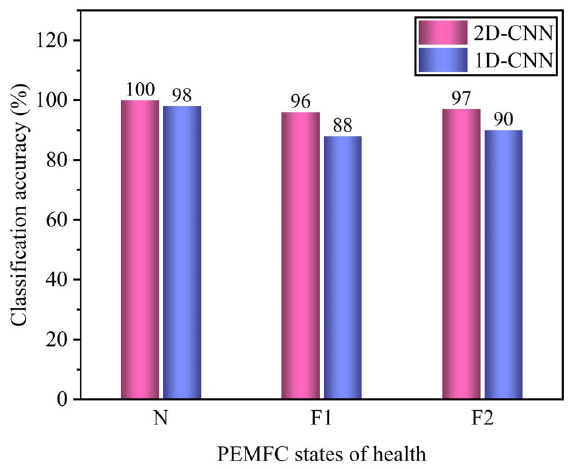
Figure 10. Classification accuracy in test sets for different PEMFC’s states of health (where N, F1, and F2 represent proper, too much, and too less water content in the PEMFC membrane).